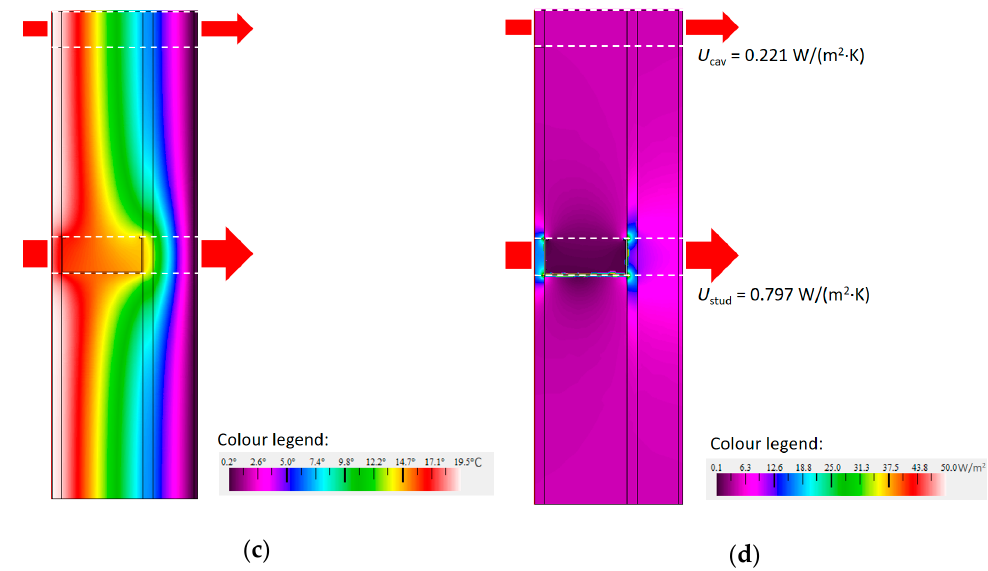
Figure 5. LSF wall element: ( a ) Frontal view of the wall steel frame; ( b ) THERM model; ( c ) Temperature color distribution; ( d ) Heat flux distribution and local 𝑈 -values.